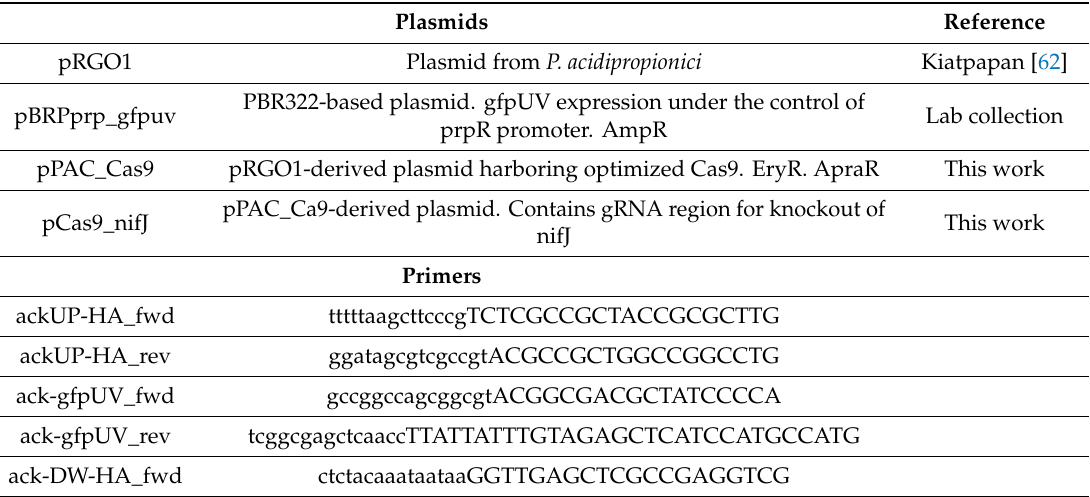
Table 2. List of plasmids and